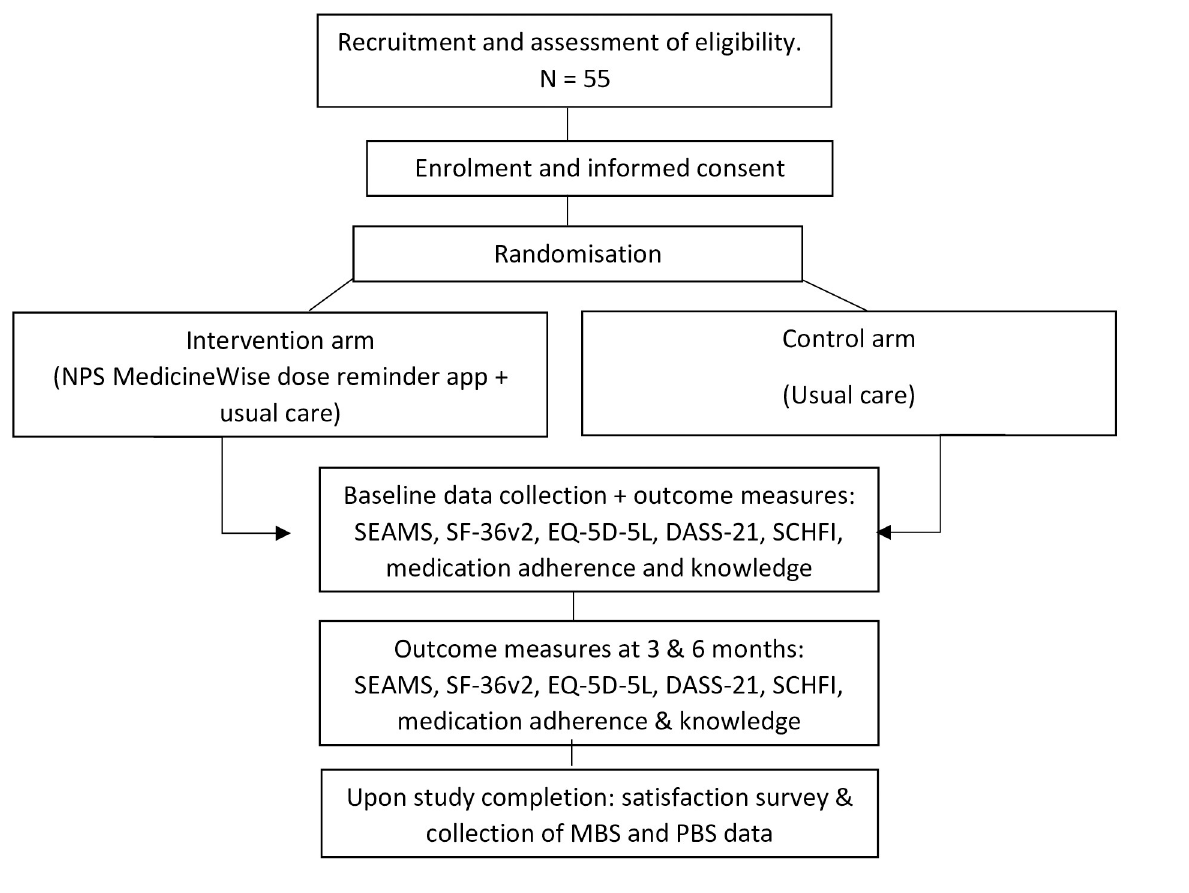
Fig 2. Schematic diagram of trial